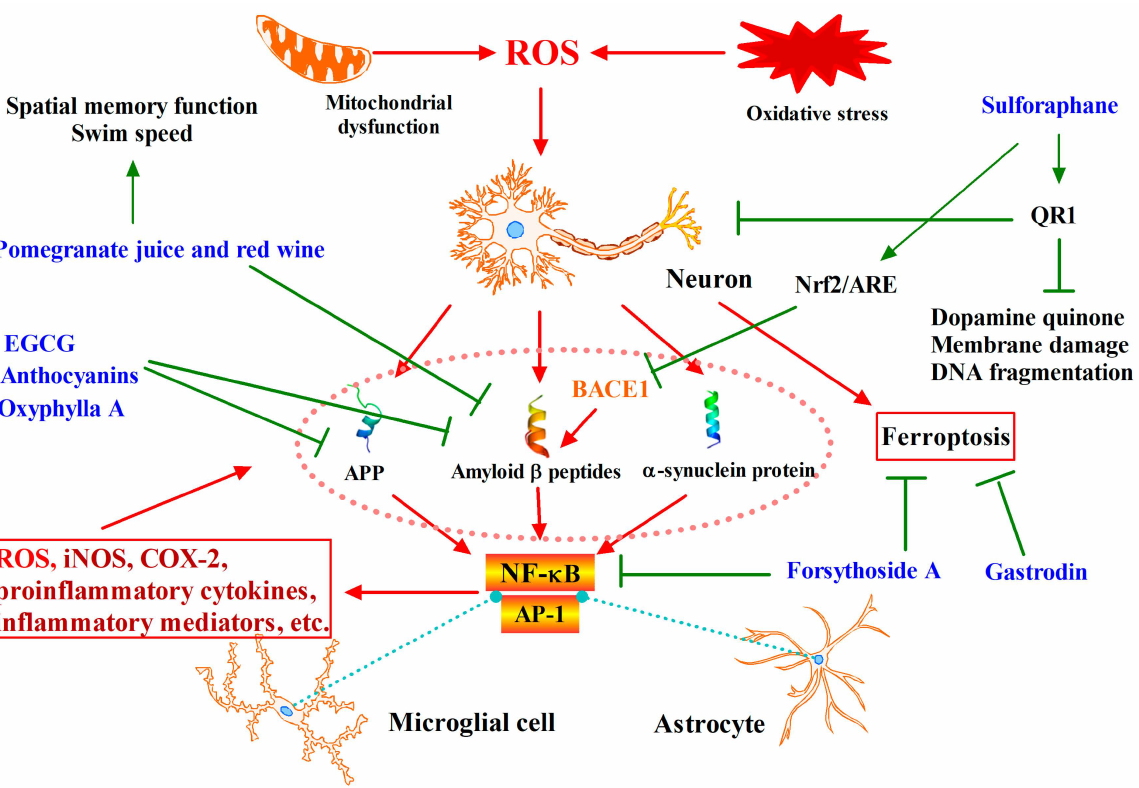
Figure 2. Phytochemicals target Nrf2 for neurodegenerative disease intervention. ROS and inflam- matory factors promote the accumulation of harmful proteins such as APP, Amyloid β peptides, α -synuclein protein, and induce ferroptosis of cells, leading to nerve cell damage. A series of phyto- chemicals are reported to prevent neuron cell damage by blocking harmful protein production and ferroptosis, thereby preventing neurodegenerative